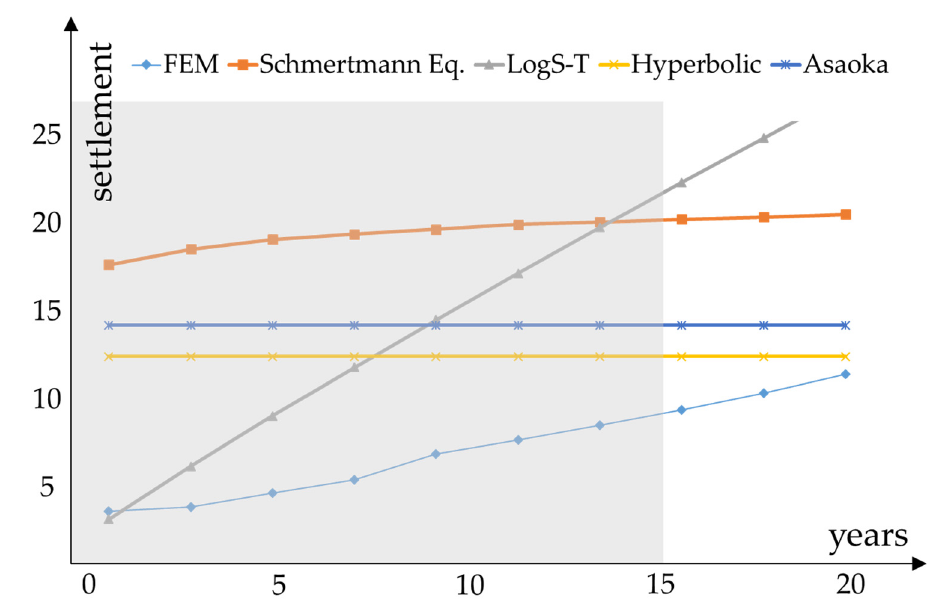
Figure 11. Long-term settlement predicted by FEM analysis. Table 6. Summary of long-term settlement analysis results of the DCM foundation method.